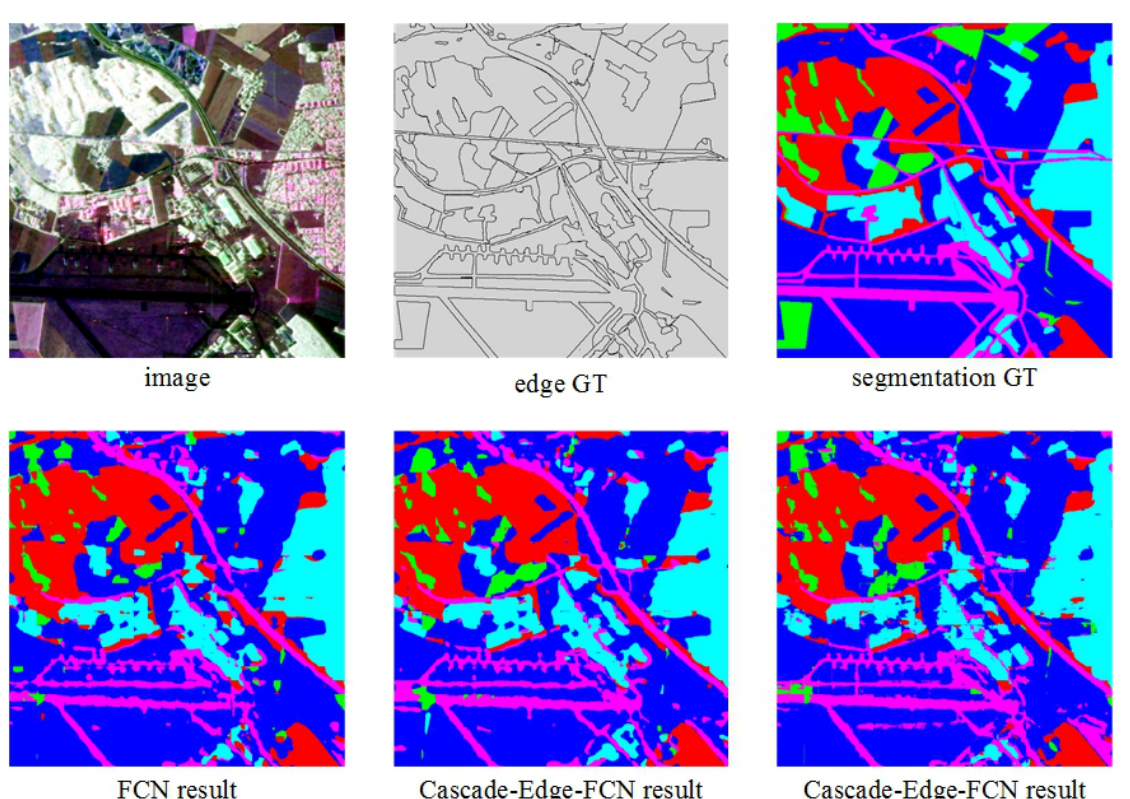
Figure 11. Image segmentation results of ESAR